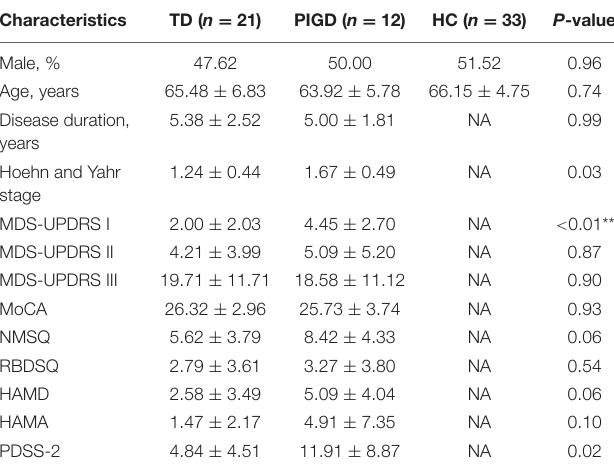
TABLE 2 | The levels of plasma biomarkers and EEG characteristic parameters in patients with PD and